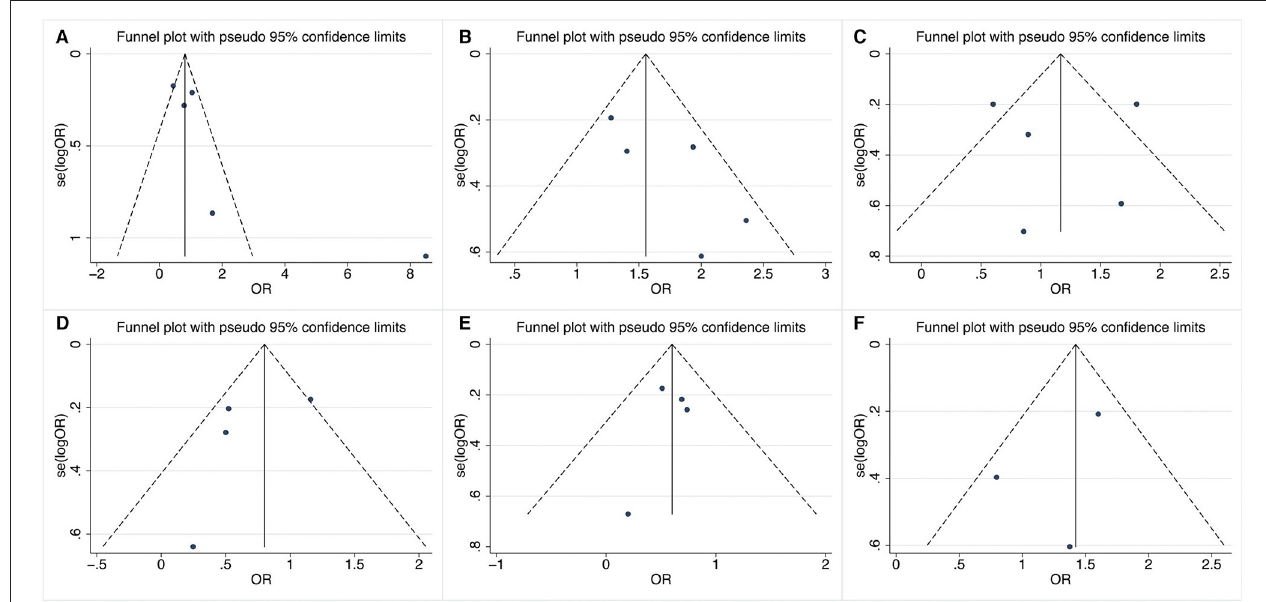
FIGURE 3 | Funnel plots of relevant factors of renal involvement in primary Sjögren’s syndrome. (A) Anti-SSA antibody; (B) anti-SSB antibody; (C) rheumatoid factor; (D) dry eyes; (E) arthralgia; (F) labial salivary gland biopsy.